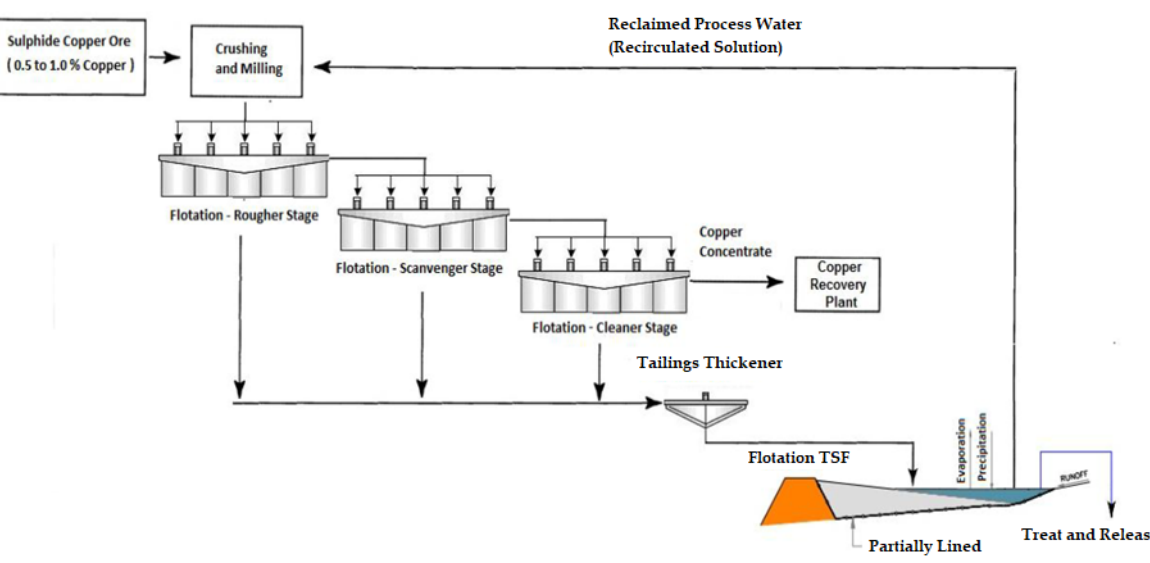
Figure 5. Typical sulphide copper ore flowsheet process—copper mine tailings management